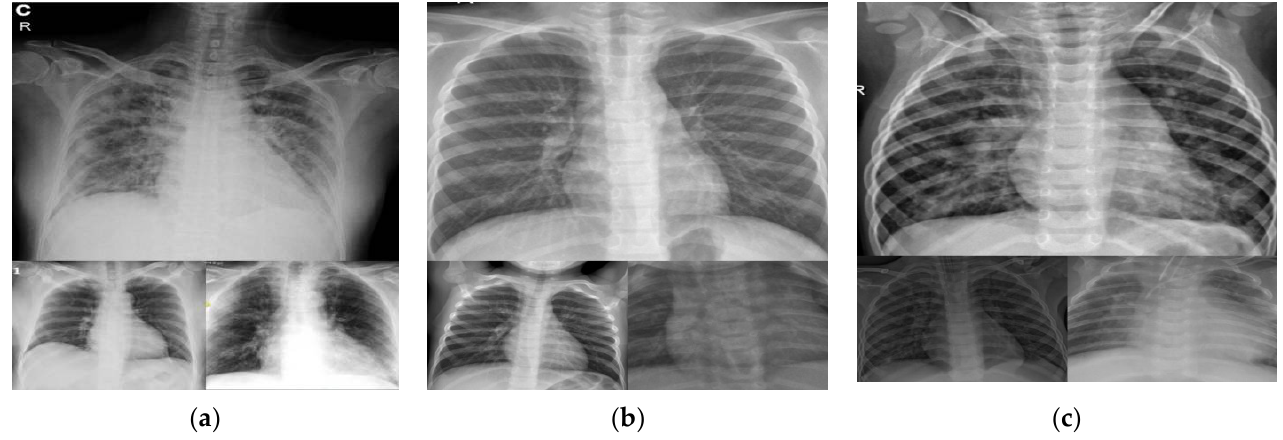
Figure 3. Sample X-ray images ( a ) COVID-19 lung X-ray images; ( b ) Healthy chest X-ray images; ( c ) Pneumonia chest X-ray images.